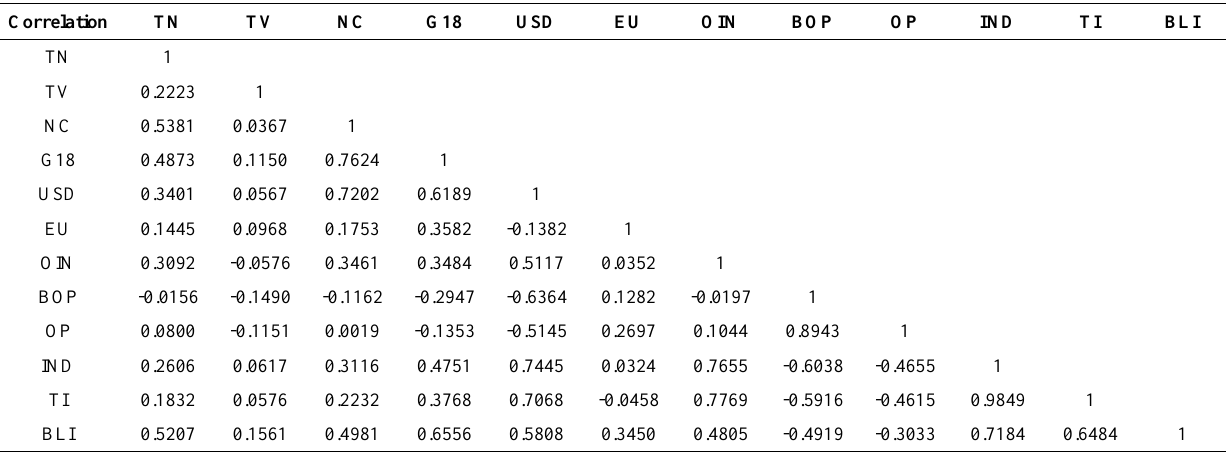
Table 3. Correlations between candidate variables (Pair wise correlations)